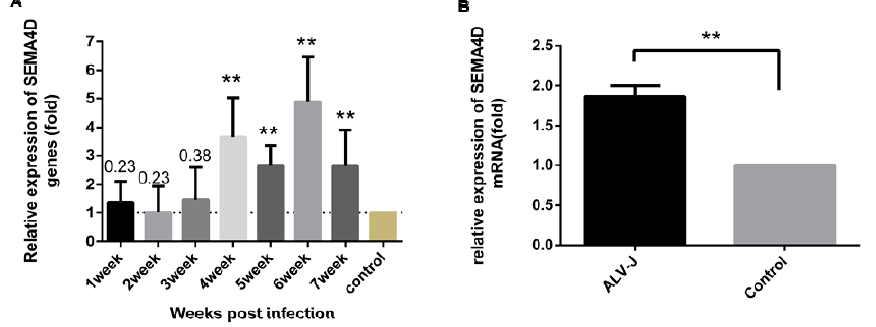
Figure 4. ALV-J up-regulates Sema4D expression in vivo and in vitro. ( A ) Sema4D expression was tested in the kidney tissue of SPF chickens infected with ALV-J by RT-qPCR at different times after infection. ( B ) Sema4D expression was tested in DF1 cells infected with ALV-J for 48 h by RT-qPCR. Data are provided as means ± standard deviation values of three replicates from a representative experiment. ** P < 0.01.